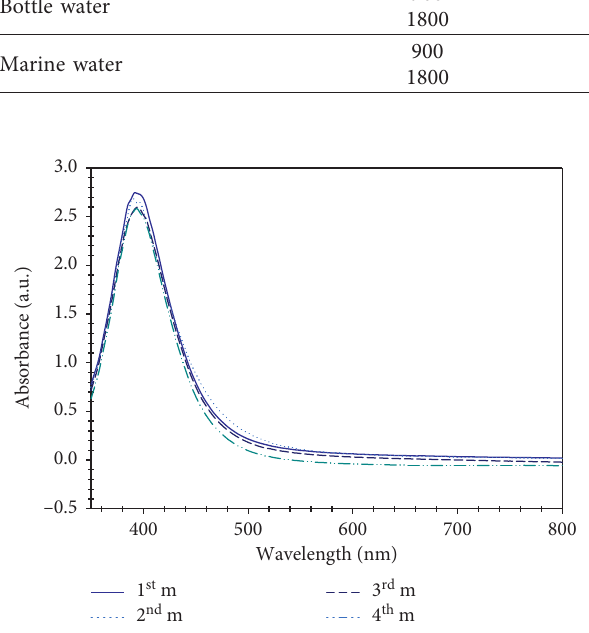
Figure 8: UV-vis spectra of the fabricated silver nanoparticles to check the stability of the fabricated silver nanoparticles for four